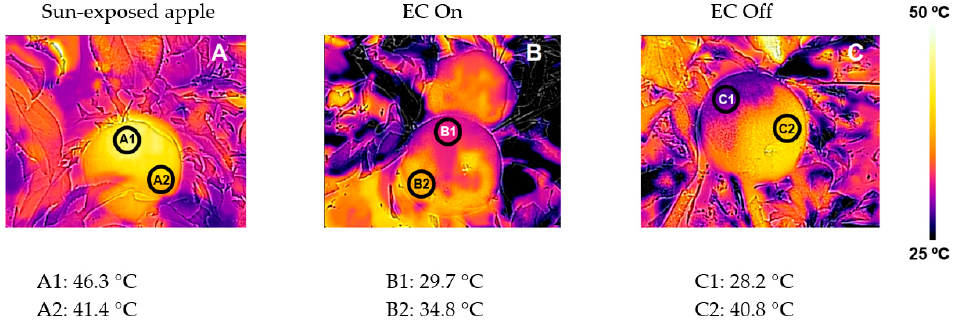
Figure 3. Fruit surface temperature (FST) of ‘Honeycrisp’ apples sun-exposed ( A ) and under evaporative cooling (EC) when the cycle is on ( B ) and 5 min after the cycle is off ( C ). FST was measured at 1630 h on 2 September 2022 in Rock Island (Washington State, USA). The air temperature was 36.6 °C, and the photosynthetically active radiation was 857 µmol m − 2 s − 1 . A1 is the most exposed part of the sun-exposed apple. A2 is the least exposed area of the sun-exposed apple. B1 and C1 are wet areas of the apples under evaporative cooling. B2 and C2 are dry areas of the apples under evaporative cooling.